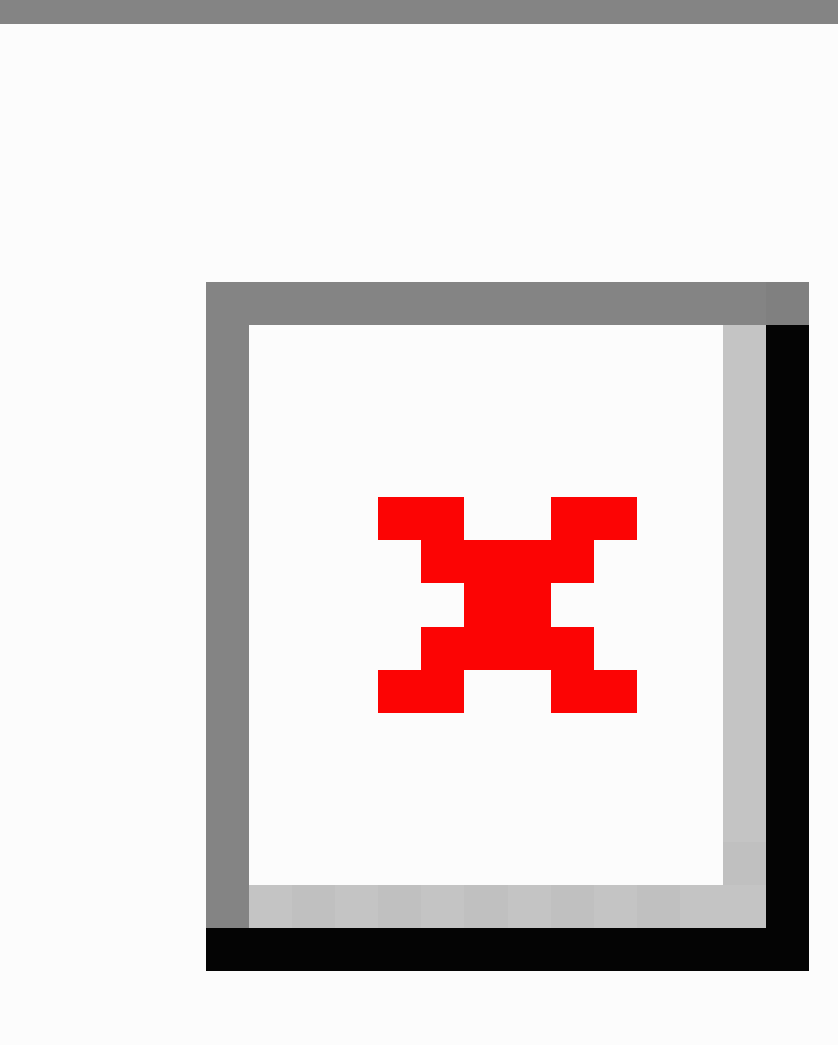
Figure 2. "Goals" function of